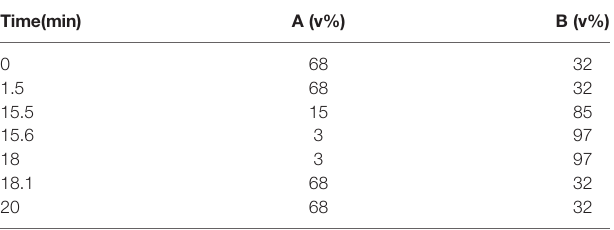
TABLE 2 | The gradient conditions for reversed phase C 8 separation for lipids.